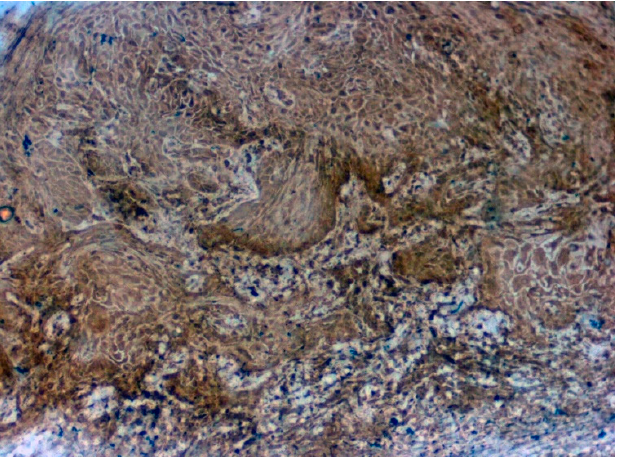
Figure 9. IHC for 14 ‐ 3 ‐ 3 ε in OSCC samples (under 20× magnification).